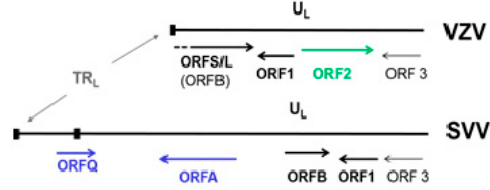
Figure 4. Sequence organization at the left ends of VZV and simian varicella virus (SVV) genomes. TR L —terminal repeat sequences; U L —leftmost part of the unique long segments. SVV ORF B is homologous to VZV ORF S / L. ORFs A and Q (blue) are present in SVV but not VZV, whereas ORF2 (green) is present in VZV but not SVV.